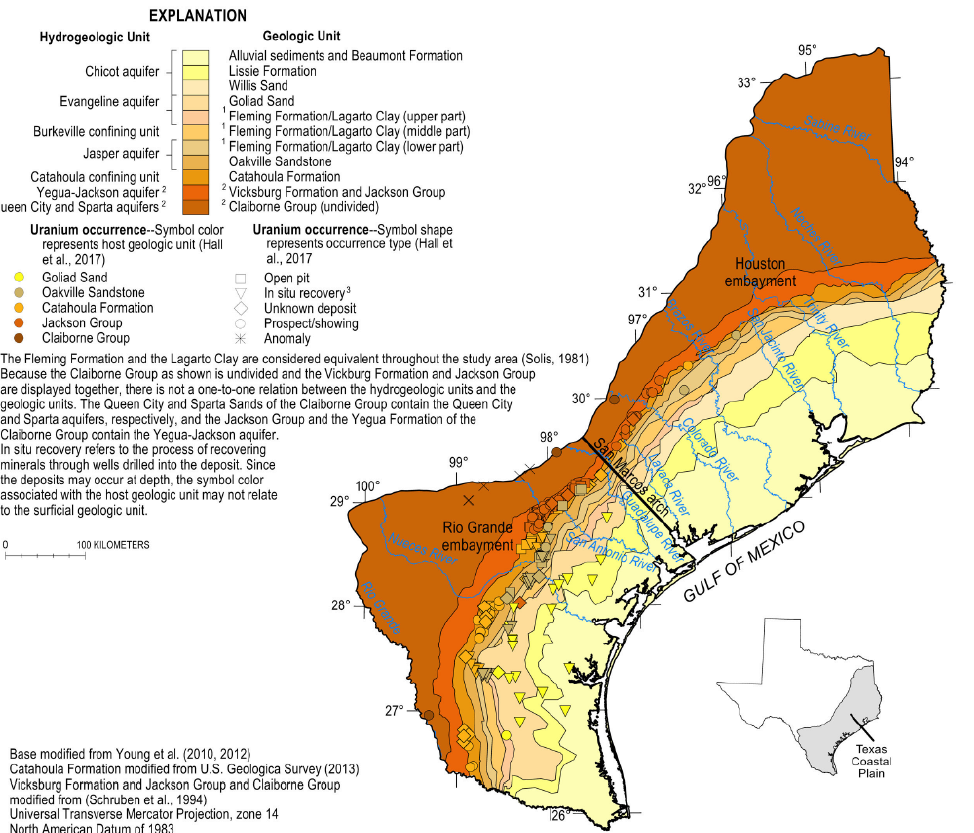
Figure 3. Geologic map and known uranium occurrences in the Texas Coastal Plain (modified from [2]). The Fleming Formation and the Lagarto Clay are considered equivalent throughout the study area [9]. Because the Claiborne Group as shown is undivided and the Vickburg Formation and Jackson Group are displayed together, there is not a one-to-one relation between the hydrogeologic units and the geologic units. The Queen City and Sparta Sands of the Claiborne Group contain the Queen City and Sparta aquifers, respectively, and the Jackson Group and the Yegua Formation of the Claiborne Group contain the Yegua-Jackson aquifer. In situ recovery refers to the process of recovering minerals through wells drilled into the deposit. Since the deposits may occur at depth, the symbol color associated with the host geologic unit may not relate to the surficial geologic unit. The base is modified from [5,6]. The Catahoula Formation is modified from [13]. The Vicksburg Formation and Jackson Group and Claiborne Group are modified from [14].